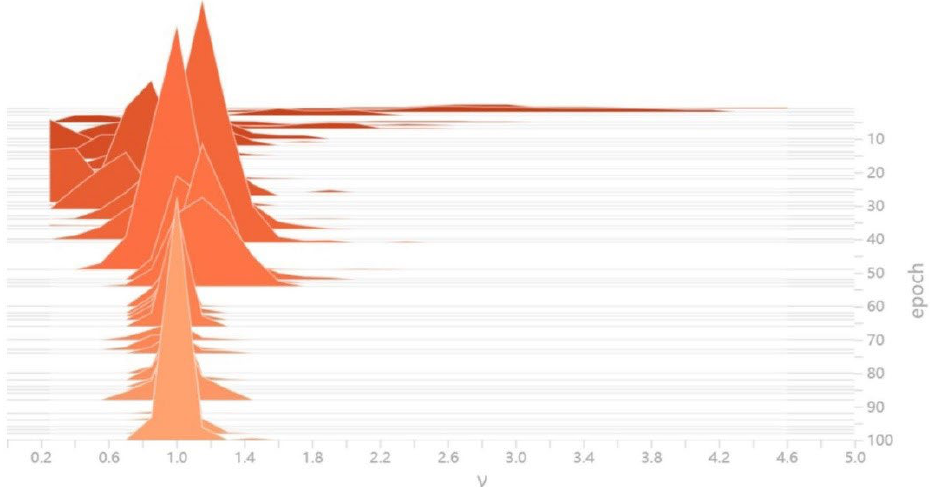
before sparse training. 𝛾𝛾